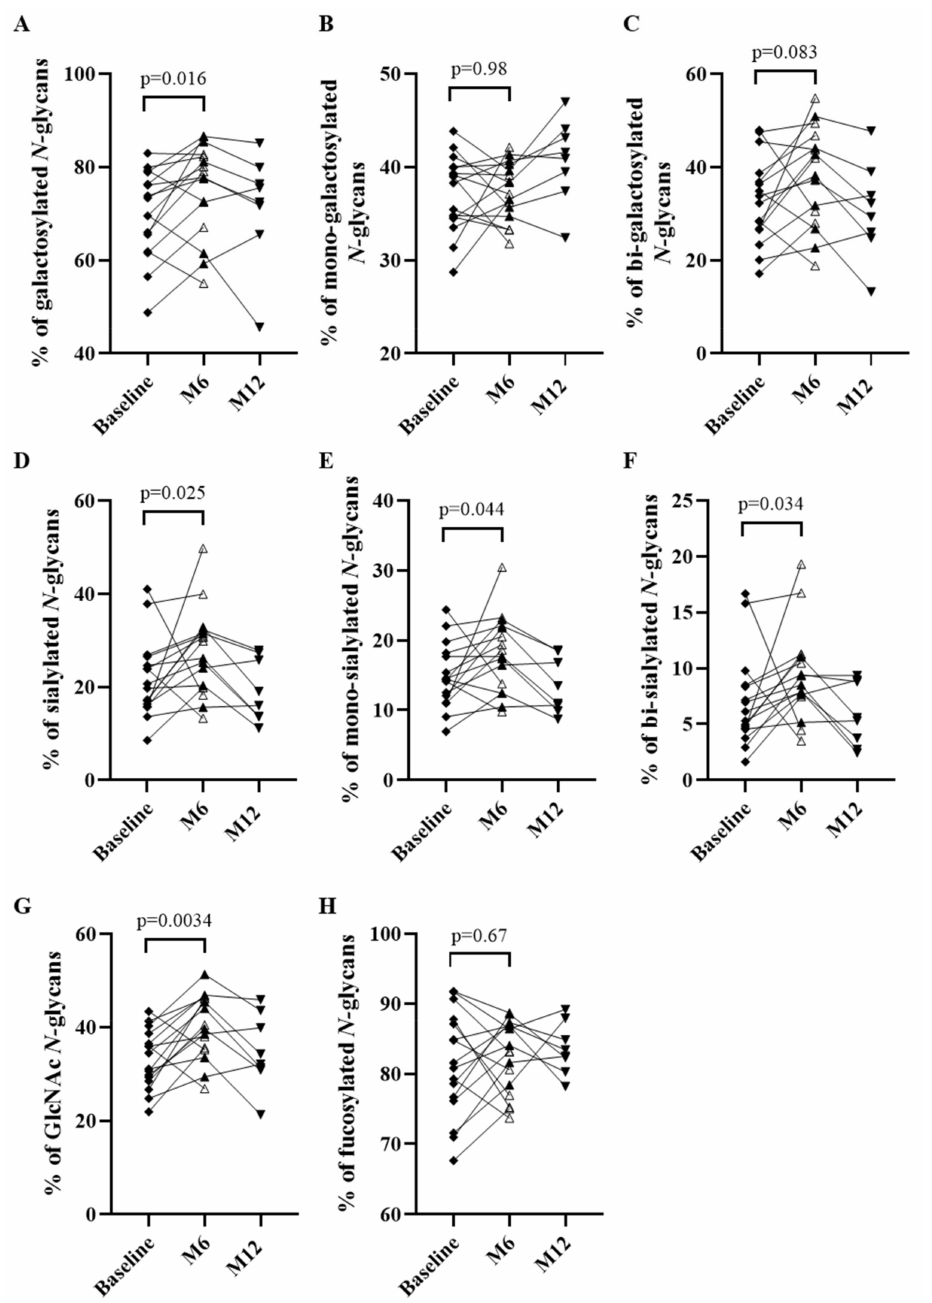
Figure 3. N- glycome evolution of pemphigus patients over time and comparison between be- fore (baseline) and 6 months (M6) and 12 months (M12) after rituximab treatment. Comparison of percentages based on relative quantification of galactosylated ( A ), mono-galactosylated ( B ), bi-galactosylated ( C ), sialylated ( D ), mono-sialylated ( E ), bi-sialylated ( F ), N- acetylglucosamine (Glc- NAc) ( G ), fucosylated ( H ) subgroups of N- glycans from IgG. Analyses were performed at baseline and M6 for all patients ( n = 16) and at M12 only for non-relapsing patients ( n = 8). Means ± standard deviations were compared using the Wilcoxon paired test. Differences were considered significant when p cor. < 0.006 with Bonferroni